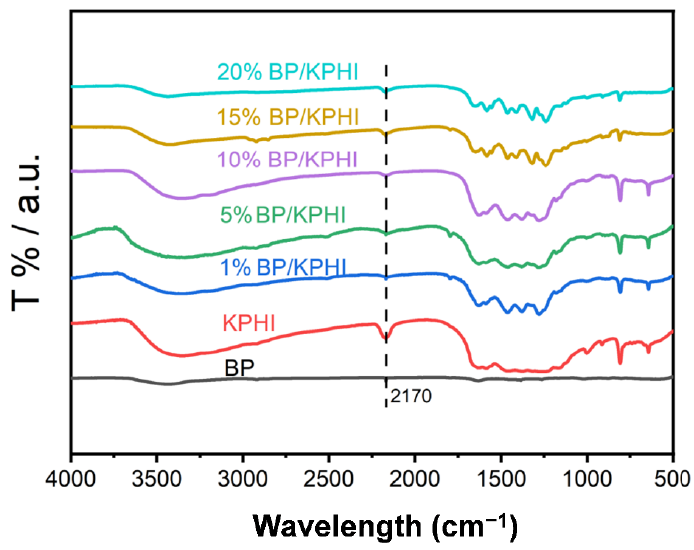
Figure 5. FT − IR spectra of BP/KPHI composites with different mass ratios, KPHI and Figure 5. FT−IR spectra of BP/KPHI composites with different mass ratios, KPHI and BP.